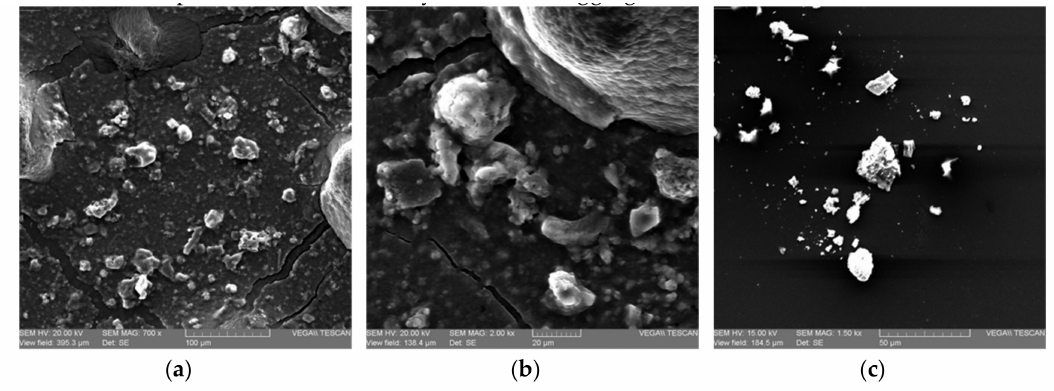
Figure 5. Scanning electron micrographs of inulin powder from: jicama at a magnification factor of: ( a ) 700 × and ( b ) 2000 × ; and cabuya at a magnification factor of ( c ) 4000 ×